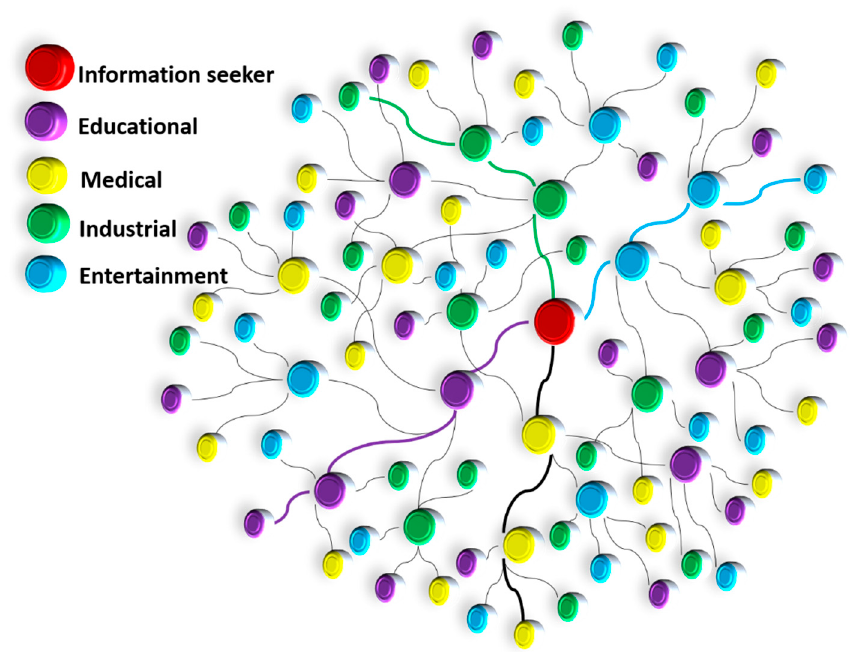
Figure 5. Searching for information or services in a small world network.